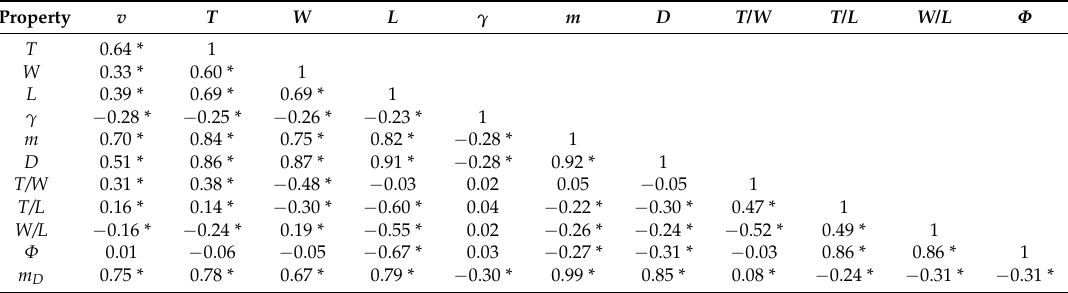
Table 3. Coefficients of linear correlation between the physical properties (indicators) of fir